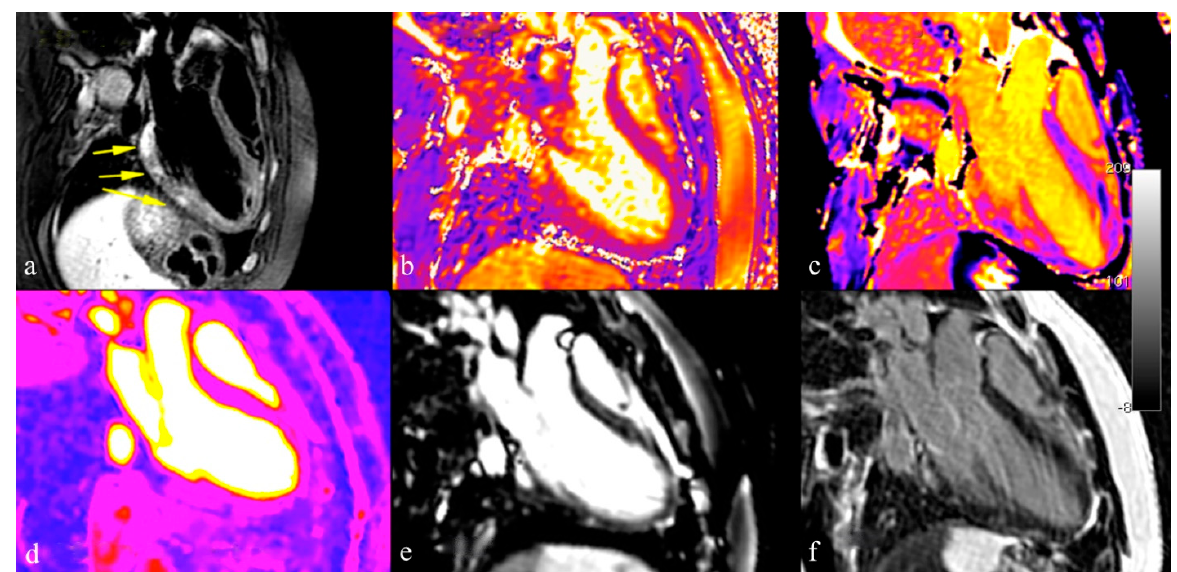
Figure 3. Different techniques for myocarditis assessment with cardiovascular magnetic resonance imaging: T2 STIR sequences reveal areas of myocardial edema in acute setting (panel a ); T1 and T2 mapping techniques improved detection of myocardial edema and inflammation (panel b , c ); perfusion imaging and early enhancement can be used to detect hyperemia condition (panel d , e ); late gadolinium enhancement sequences confirmed acute myocardial inflammatory damage and assessment of myocardial fibrosis (panel f ).